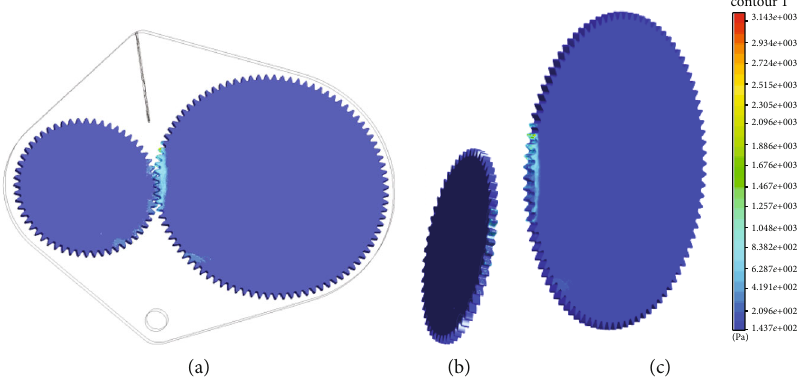
Figure 9: Viscous force distribution nephogram of gear pair (a) the gear pairs, (b) the pinion, and (c) the gear. Table 8: Turbulent kinetic energy and dissipation rate with di ff erent oil jet